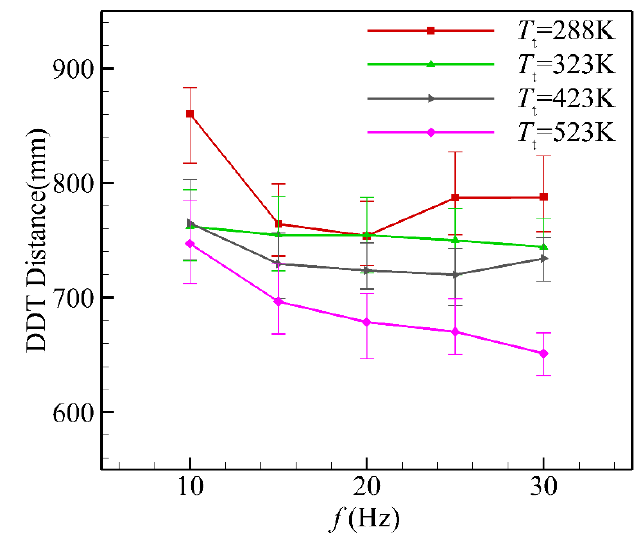
Figure 6. The DDT distance of PDC at different working conditions.